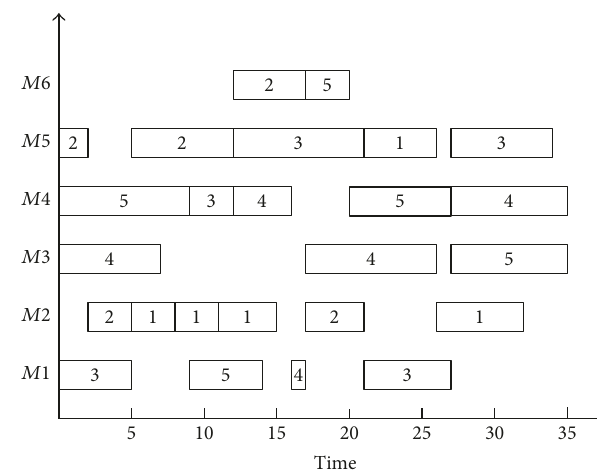
Figure 14: Rescheduling Gantt chart after 𝑀6 failure.